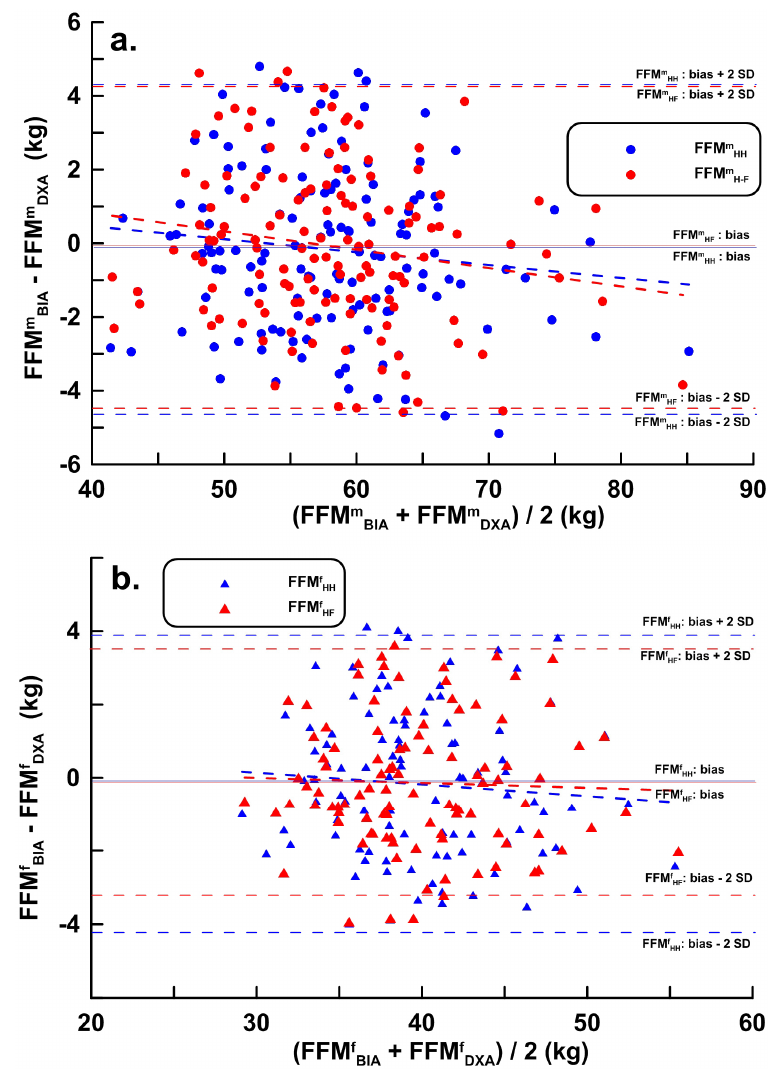
Figure 5. Scatter plots and regression lines for the validation of fat free mass (FFM HH and FFM HF ) estimated using dual-energy X-ray absorptiometry or bioelectrical impedance analysis (BIA) for ( a ) male subjects ( n = 134; FFM m HH : bias = − 0.164 kg, LOA: − 4.616–4.289 kg, y = 1.865 − 0.031 x , r = 0.118, p = 0.173; FFM m HF : bias = − 0.070 kg, LOA: − 4.395–4.255 kg, y = 2.613 − 0.043 x ( r = 0.127, p = 0.062); and ( b ) female subjects ( n = 100; FFM f HH : bias = − 0.178 kg, LOA: − 4.271–3.916 kg, y = 1.103 − 0.032 x , r = 0.079, p = 0.434; FFM f HF : bias = − 0.137 kg, LOA: − 3.750–3.476 kg, y = 0.409 − 0.014 x , r = 0.038, p = 0.703).